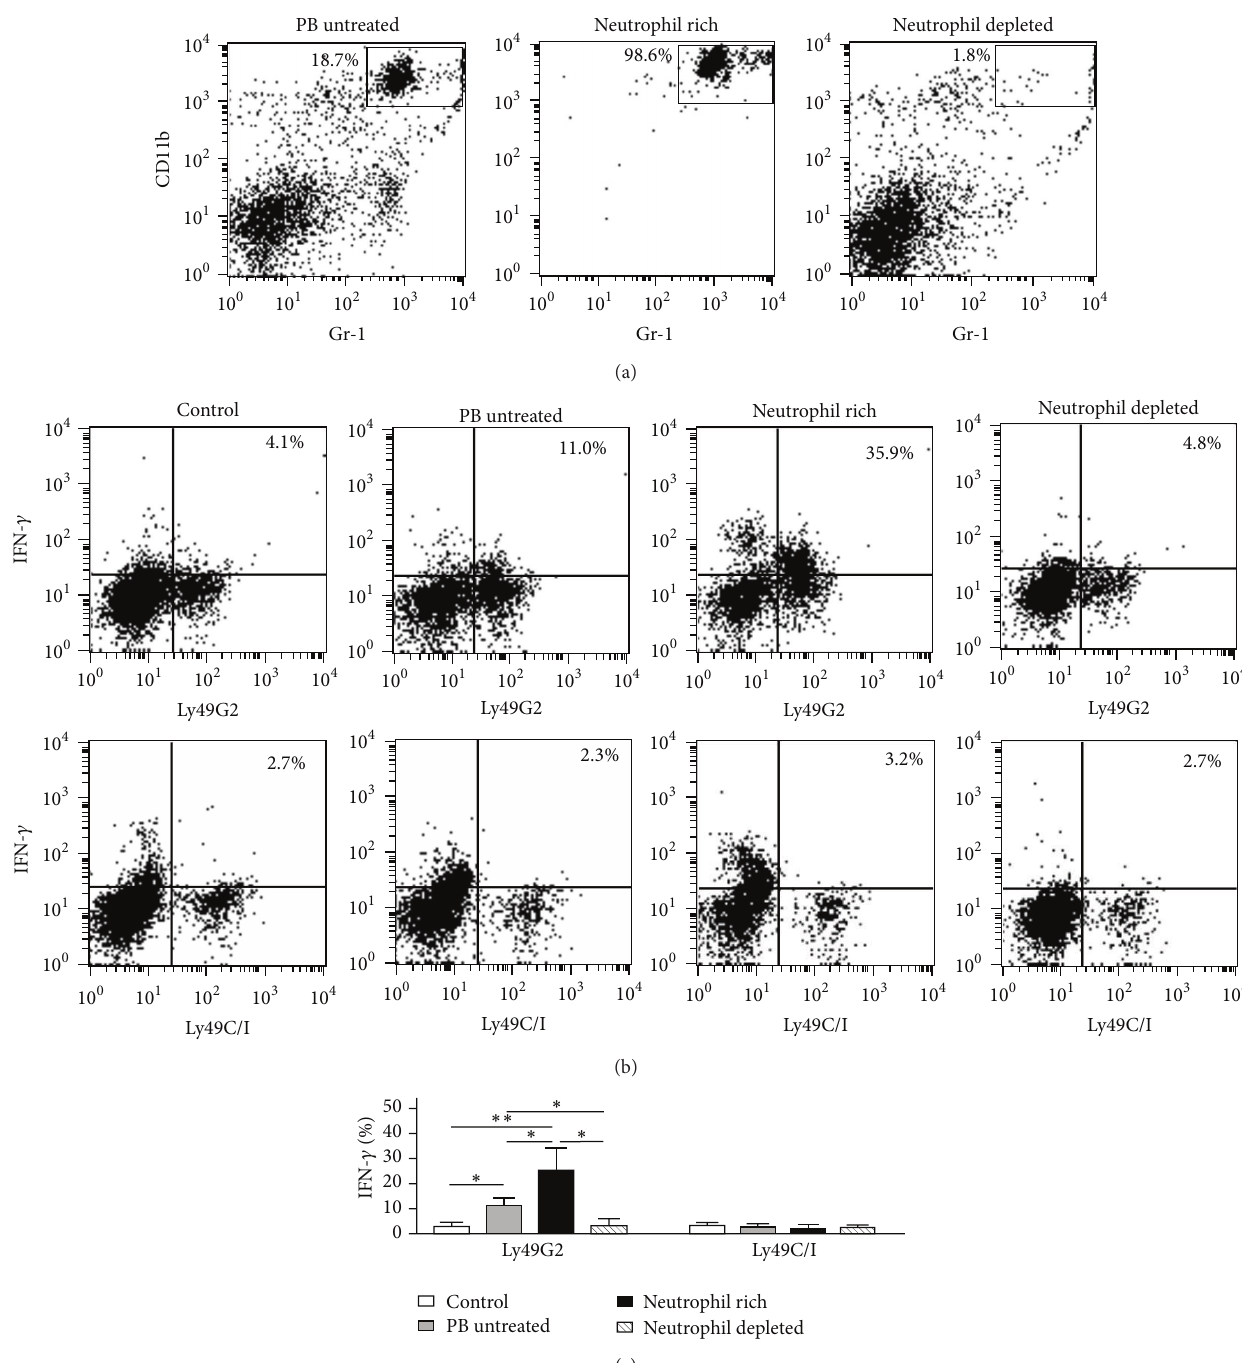
Figure 4: Enrichment and depletion of neutrophils affect licensing effect of NK cells. B10.D2 PB was enriched or depleted of CD11b + Gr-1 +